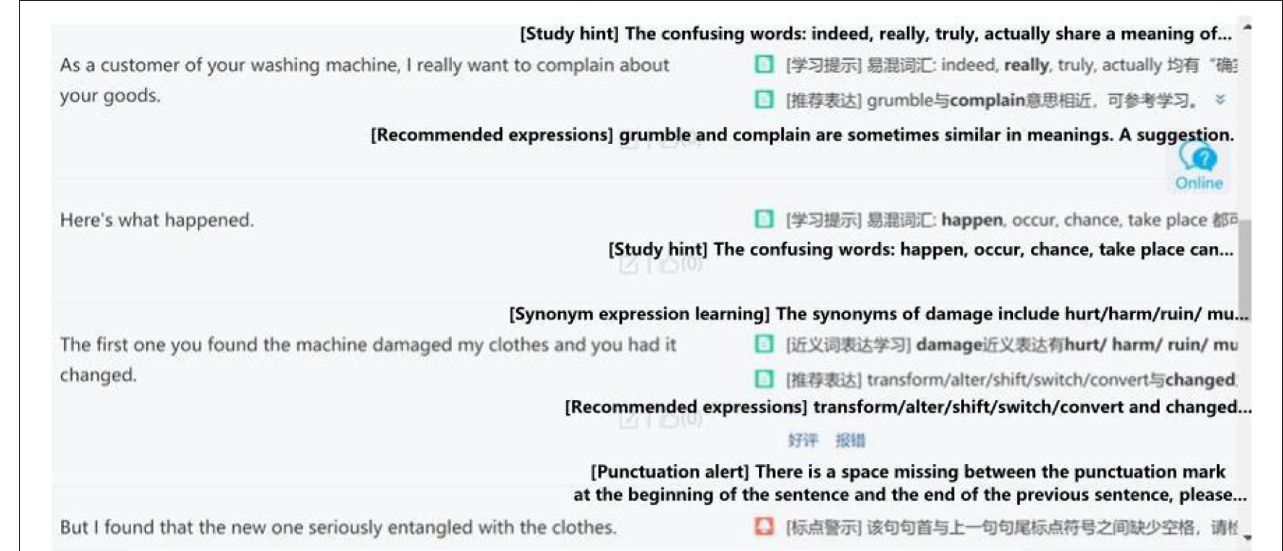
FIGURE 5 | Pigai—Revision